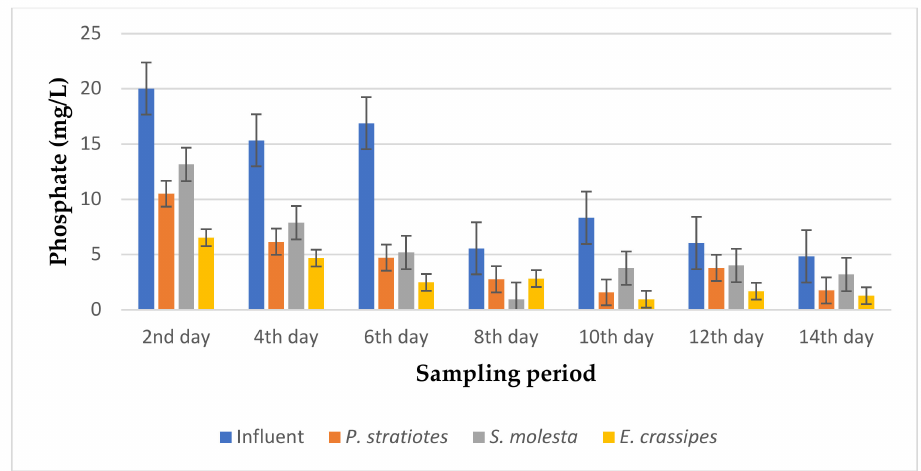
Figure 8. Bar plot of the average phosphate vs. the sampling period with a 24 h retention